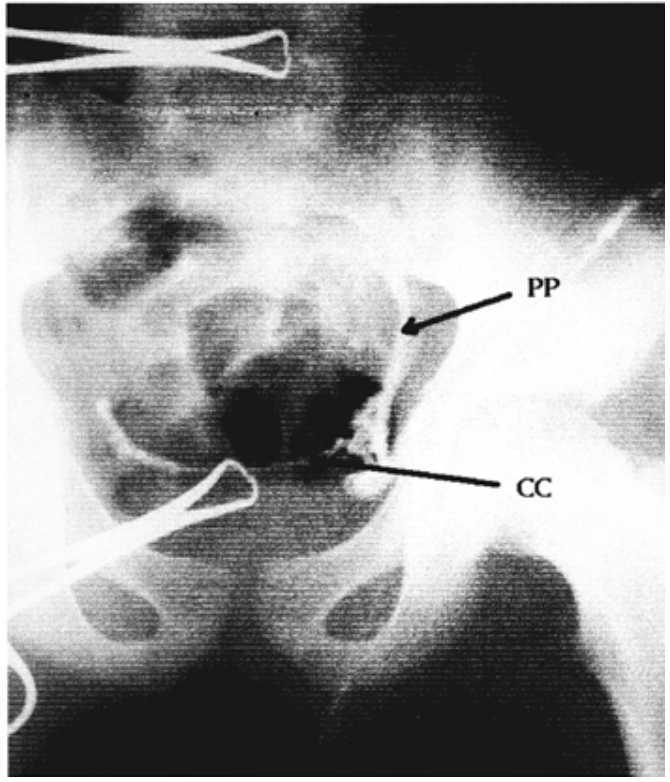
FIGURE 2 . Intraoperative venogram showing left to right cross-communicating veins CC-cross-communications, PP-pampiniform plexus